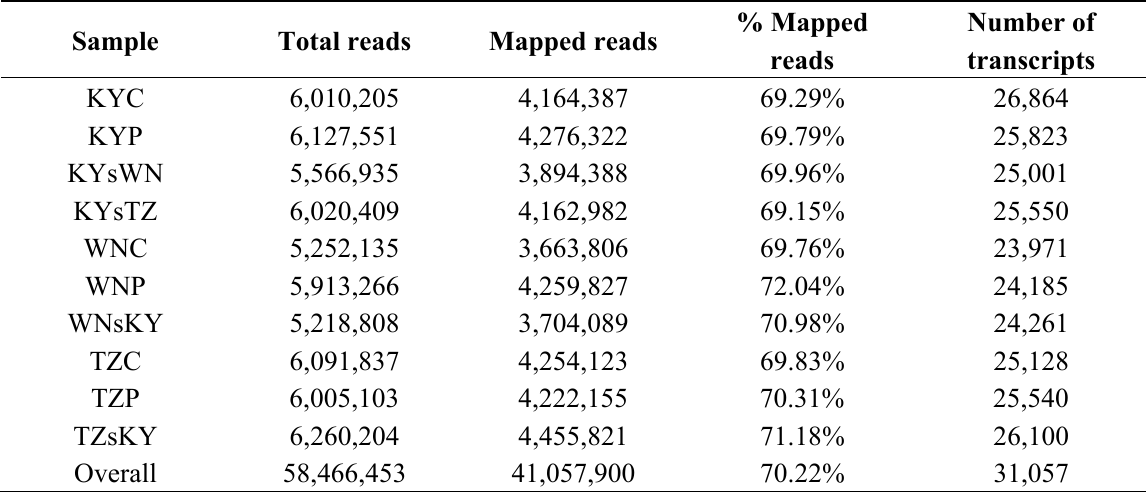
Table 1. Summary of RNA-seq reads mapping to reference